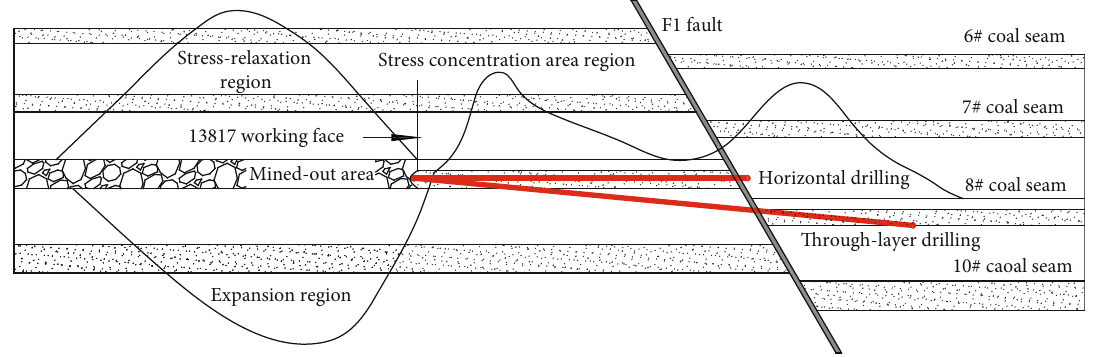
Figure 7: The schematic diagram of 13817 working face advancing towards fault along